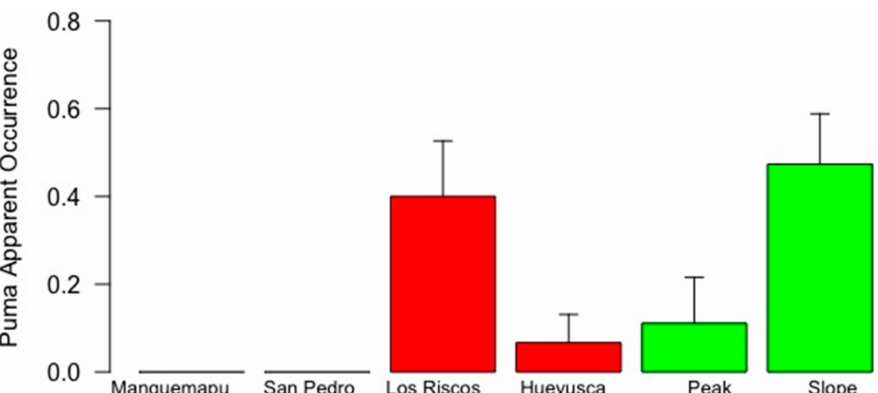
Figure 2. Puma apparent occurrence in six locations of the coastal range of southern Chile (whiskers represent 1 standard error). White, red and green bars identify coast, pre-mountain range and mountain range landscapes, characterized by intermediate, high and low degrees of human intervention, respectively.